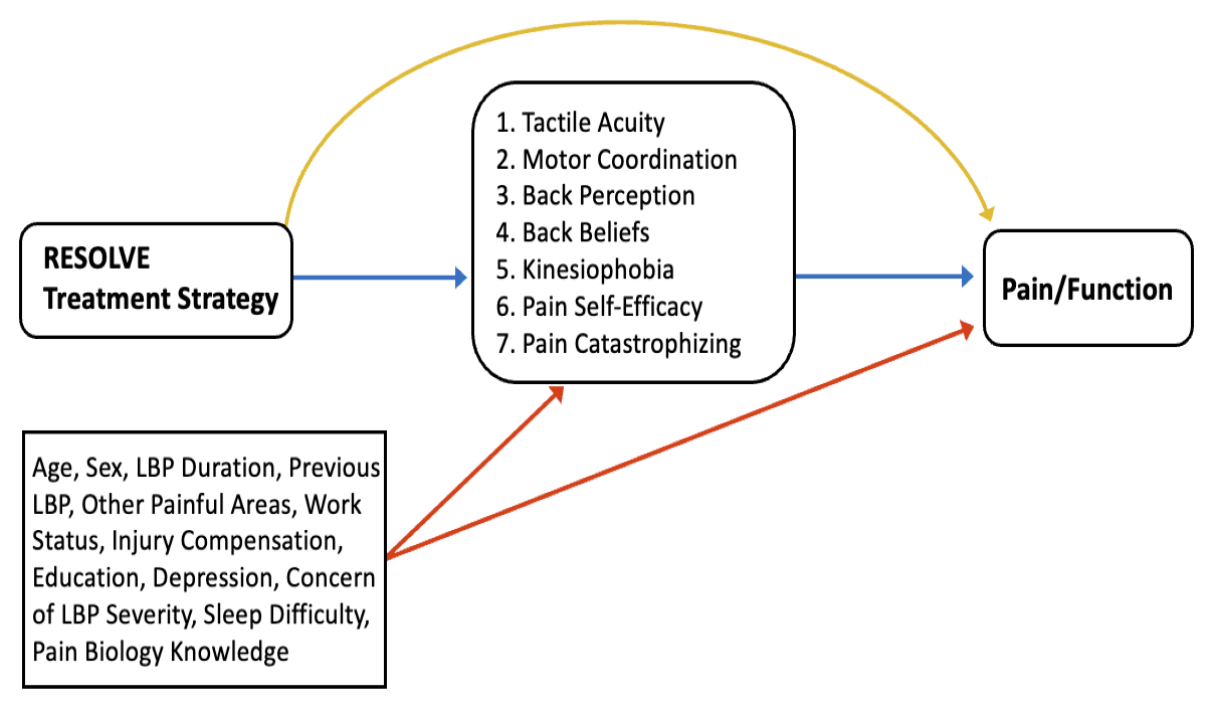
Figure 1. Simplified causal pathways for the effect of the RESOLVE treatment on the outcomes, pain intensity and function, via the hypothesized mediators. The mediators are measured at the end of treatment. Outcomes are measured at 18 weeks after randomization. The potential confounders are measured at baseline. The diagram assumes independence of mediators. The treatment–mediator relationship is represented by the blue line from the RESOLVE treatment to the mediators. The mediator–outcome relationship is represented by the blue line from the mediators to the outcomes. The potential confounders of the mediator–outcome relationship are represented by the red lines. The direct effect of treatment on the outcome is represented by the yellow